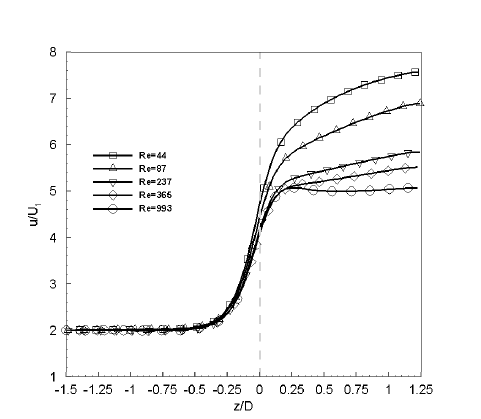
Figure 3. Axial velocity profiles through the centreline at various Reynolds numbers.